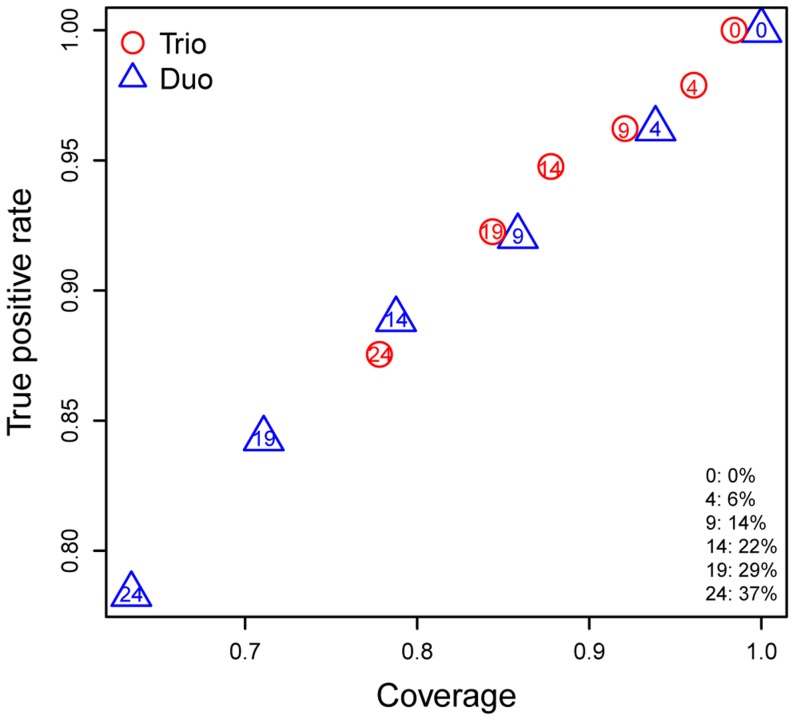
Comparison of sample alignment procedures based on three or two data types in simulated datasets.A total 65 COPD samples with all three types of data (gene expression, genotype, and methylation) were used. The mis-labeling error rates were fixed at 3% between gene expression and genotypes. The number of mis-aligned pairs was varied from 0 to 24 (corresponding error rate, 0% to 37%). Two sample alignment procedures were applied to the simulated data sets and final aligned pairs were compared with the true alignment. Triangles, duo-alignment results; circles, trio-alignment results. Numbers inside triangles or circles indicate the number of mis-aligned samples in each simulation. Coverage is defined as the number of correctly aligned pairs divided by 65 (the number of original pairs). The true positive rate is defined as the number of correctly aligned pairs divided by all aligned pairs.